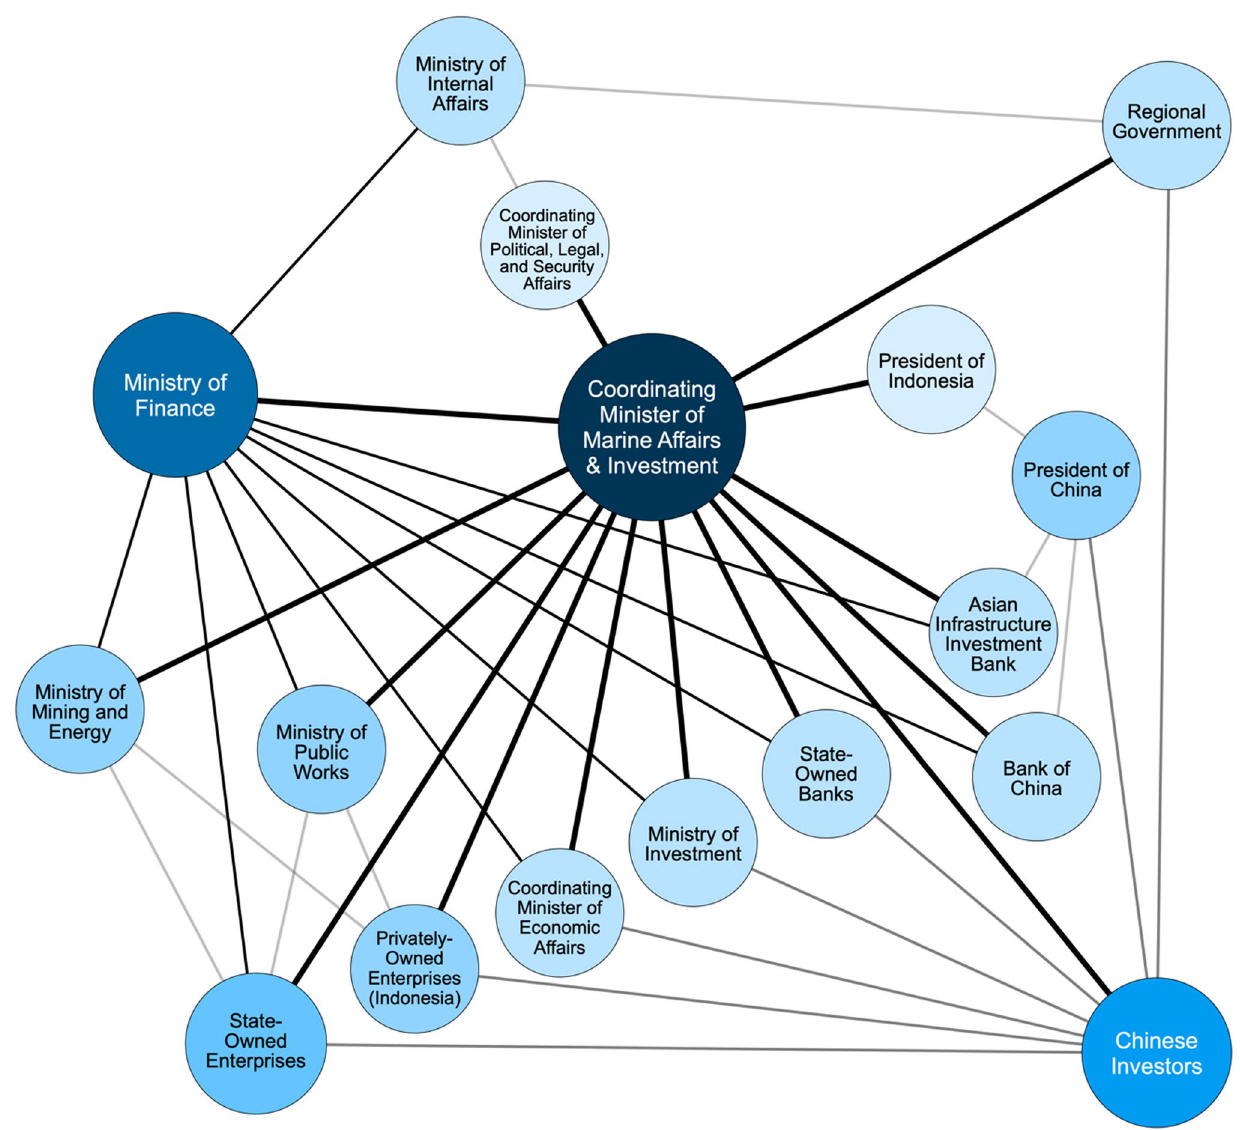
Fig. 3 Complexity in the financial flows of Chinese investment in Indonesian Belt and Road Initiative (BRI) projects between diverse actors increases the burden on state budgets and risks inefficiencies in project management and